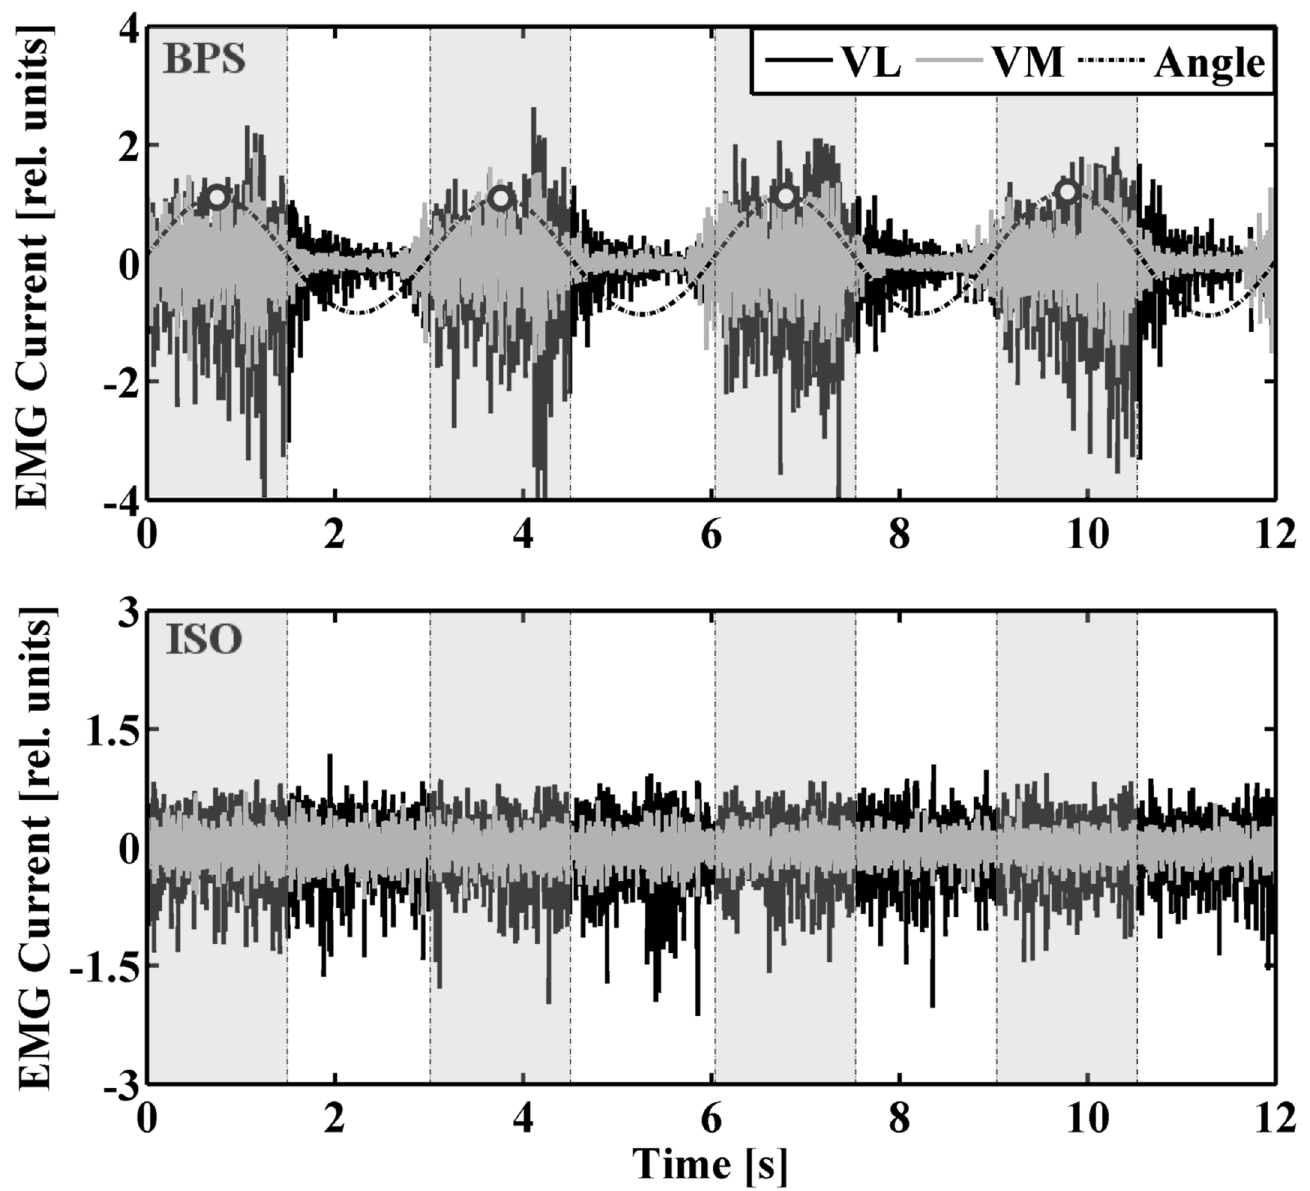
Fig 3. Procedure to separate individual data sequences according to peaks in knee flexion angle. Example for a bipedal squat (top panel) and corresponding isometric squat (bottom panel). Dashed vertical lines to the left and right of peaks in the knee flexion angle trace indicate the boundaries of individual data sequences (shaded) that were used for further